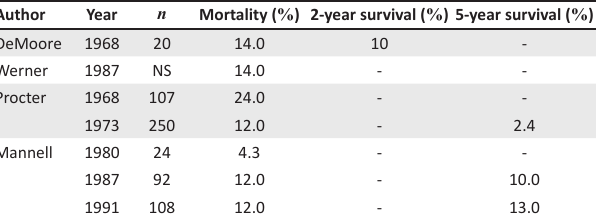
TABLE 3: Studies on curative surgery for oesophageal cancer. Author